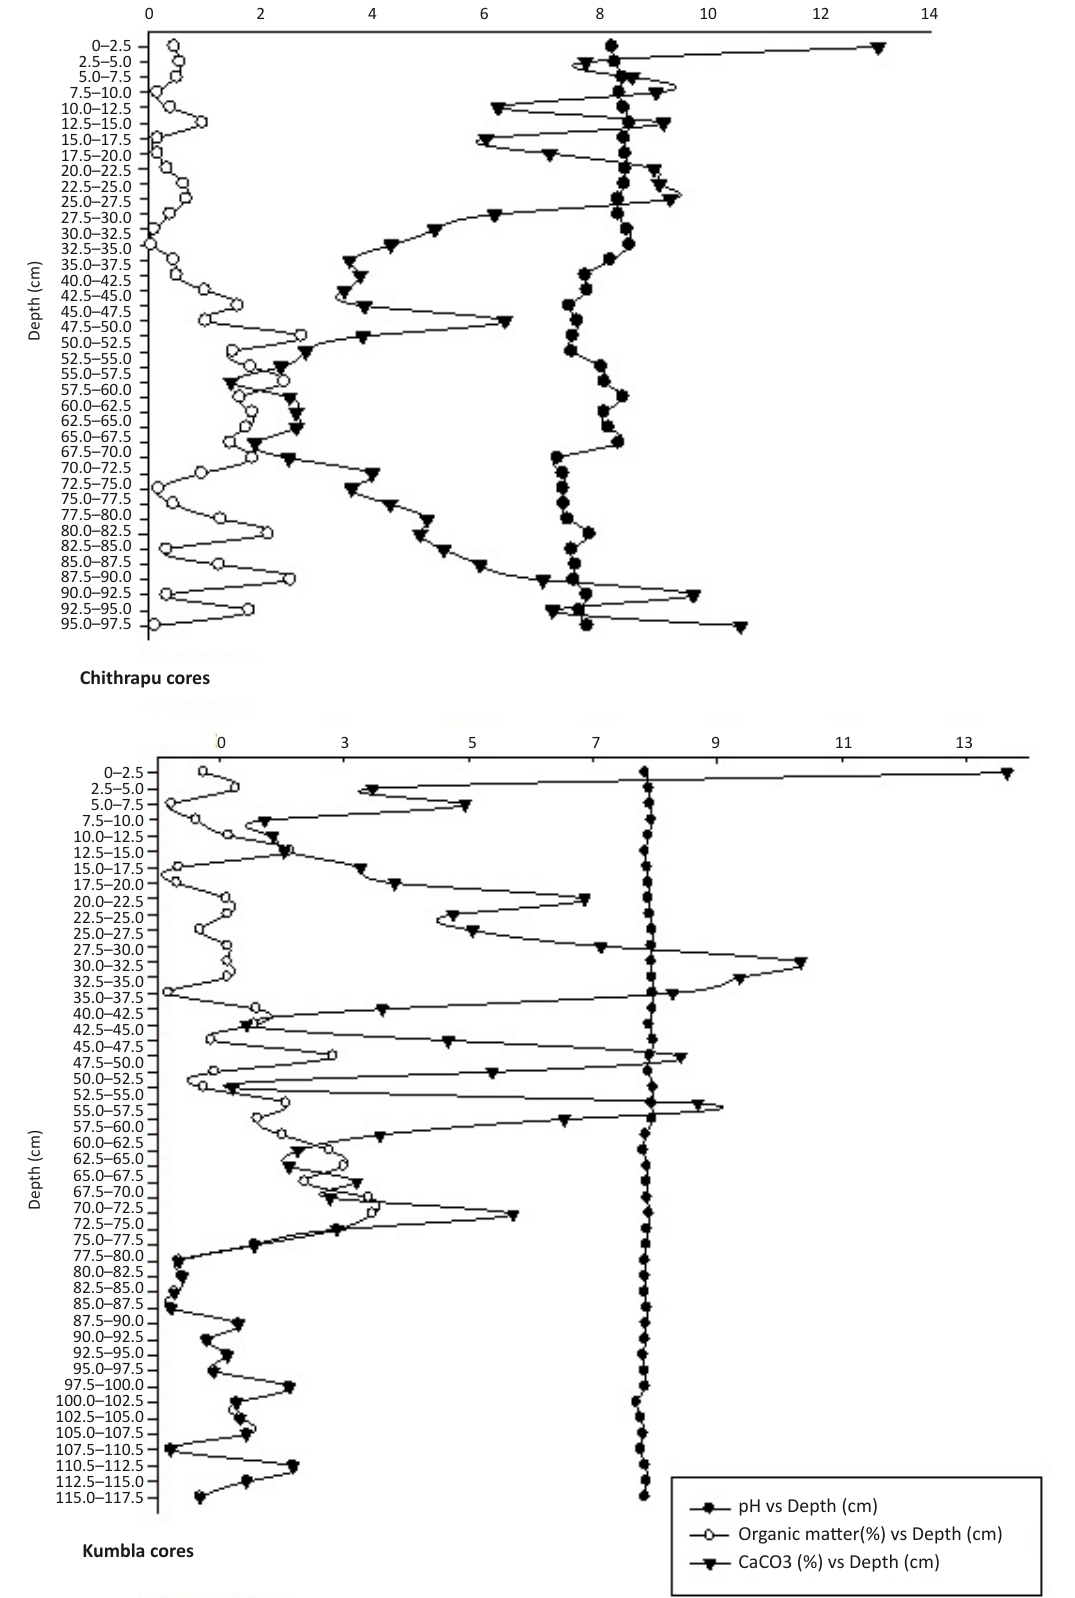
Figure 3. Down core depth profile of pH, organic matter and calcium carbonate in